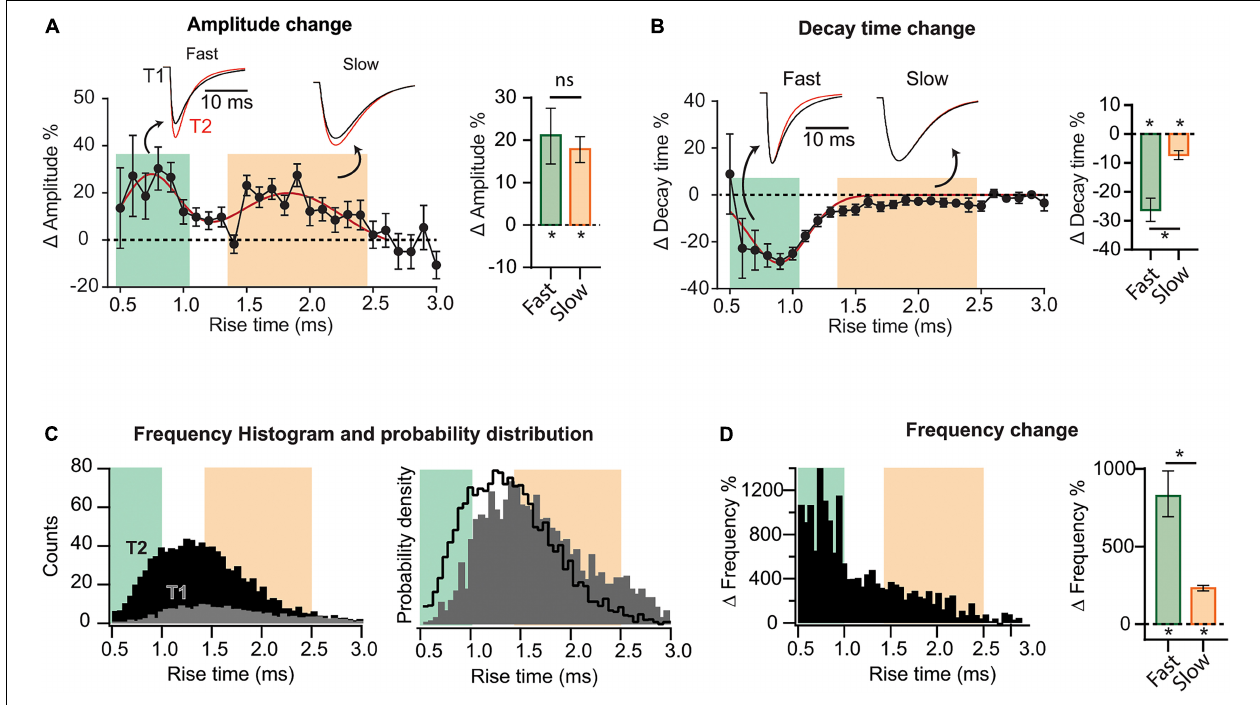
FIGURE 2 | Heterogeneous synaptic adaptations in different groups of synapses. All mEPSCs recorded at a time interval (T1 or T2) were pooled together and sorted by rise time ( τ r ). (A) Left, distribution of mEPSC amplitude percent changes for τ r -binned data (0.1 ms). The red curve corresponds to a bimodal fit (fast and slow-rising mEPSCs). Insets, superimposed average traces for T1 (black) and T2 (red), rise-time values indicated by the arrows. Data was separated into fast and slow rising groups using a 95% confidence interval obtained from the multi-peak fit. Right, mean amplitude percent increase for slow and fast-rising mEPSC. (B) Left, decay time ( τ d ) percent change distribution for τ r -binned data. Right, decay time change summary plot for slow- and fast-rising mEPSC. (C) Left, superimposed frequency histograms for all events recorded at T1 or T2. Right, probability density curves showing a relative increase in the incidence of fast-rising events. (D) Left, τ r -binned frequency percent increases. Right, average frequency increase for fast and slow events. Bootstrap with Bonferroni correction [bar plots in panels (A,B,F) ]. N = 9 cells for T1 and N = 8 for T2 (same data as for Figure 1 ). ∗ p <